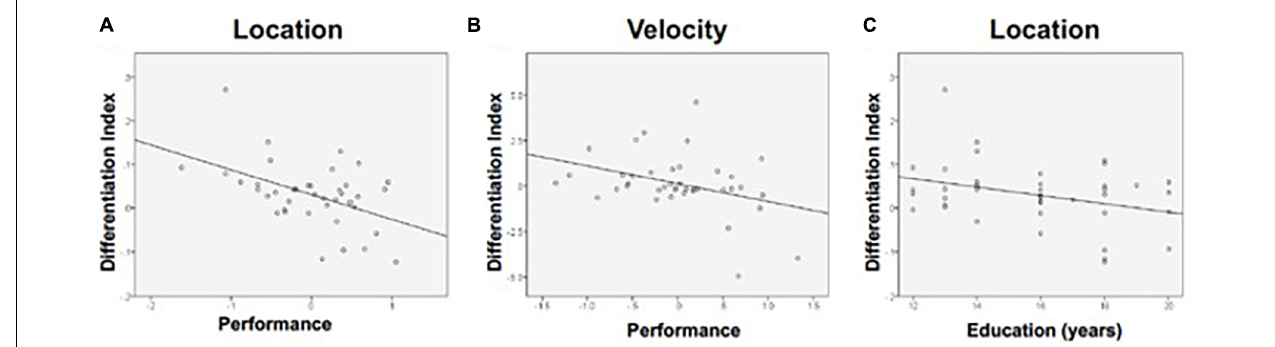
FIGURE 5 | Differentiation was negatively associated with (A) Location performance, (B) Velocity performance, and (C) Education (during location discrimination only). Performance is a composite z -score of response time and